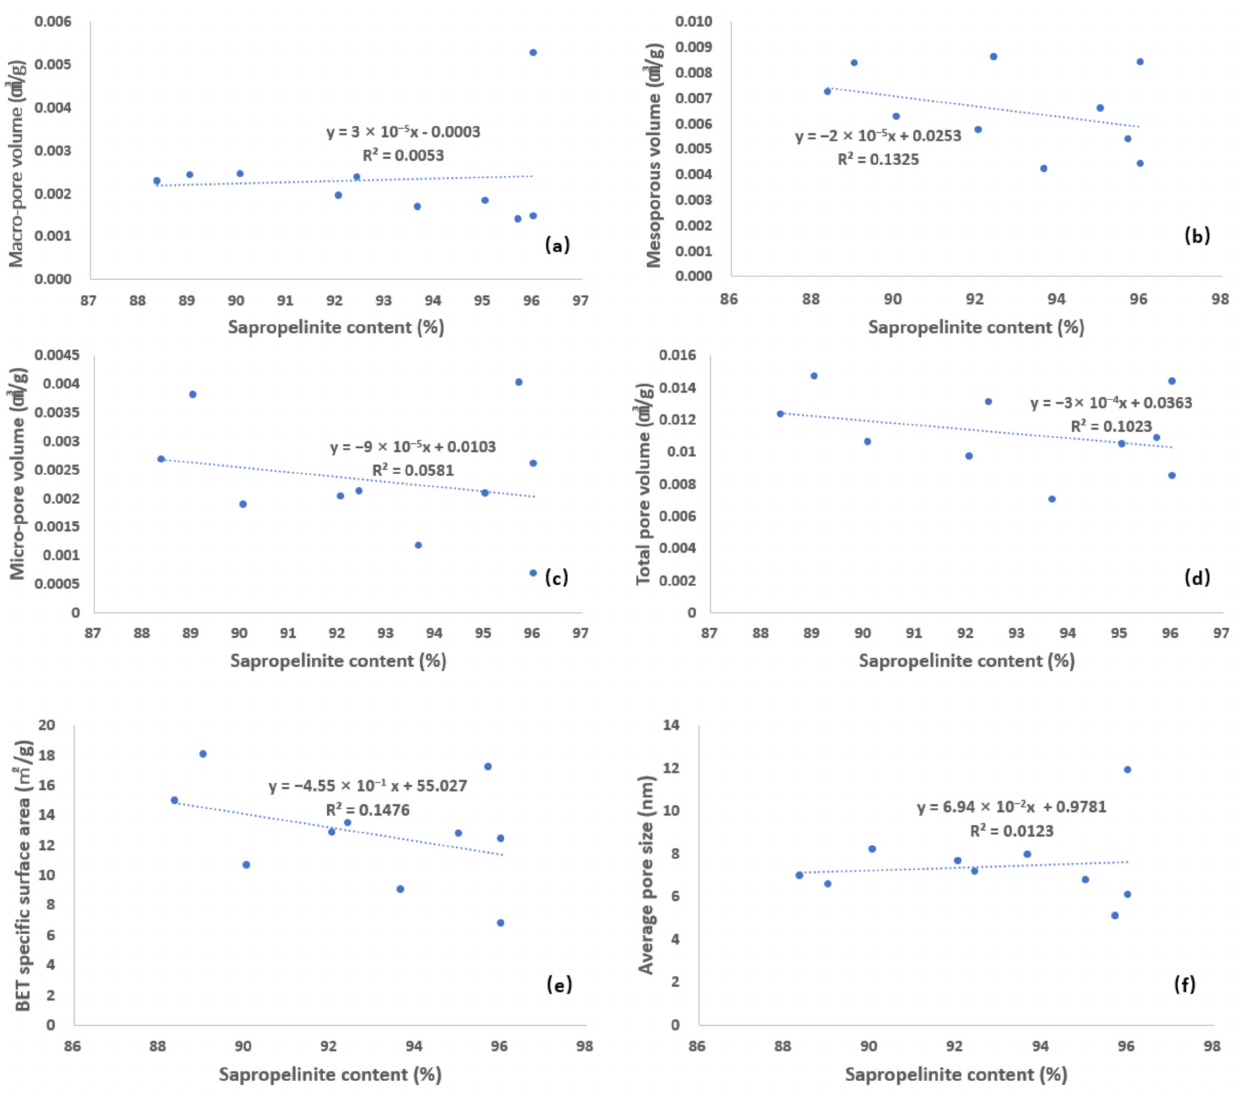
Figure 8. Relationship between micropores of lower Cambrian black shale and sapropelinite content from the Niutitang formation in Wenshuicun section, Guizhou province; ( a ) the cross plot of macropore volume and sapropelinite content; ( b ) the cross plot of mesoporous volume and sapropelinite content; ( c ) the cross plot of micropore volume and sapropelinite content; ( d ) the cross plot of Total pore volume and sapropelinite content; ( e ) the cross plot of BET specific surface area and sapropelinite content; ( f ) the cross plot of average pore size and sapropelinite